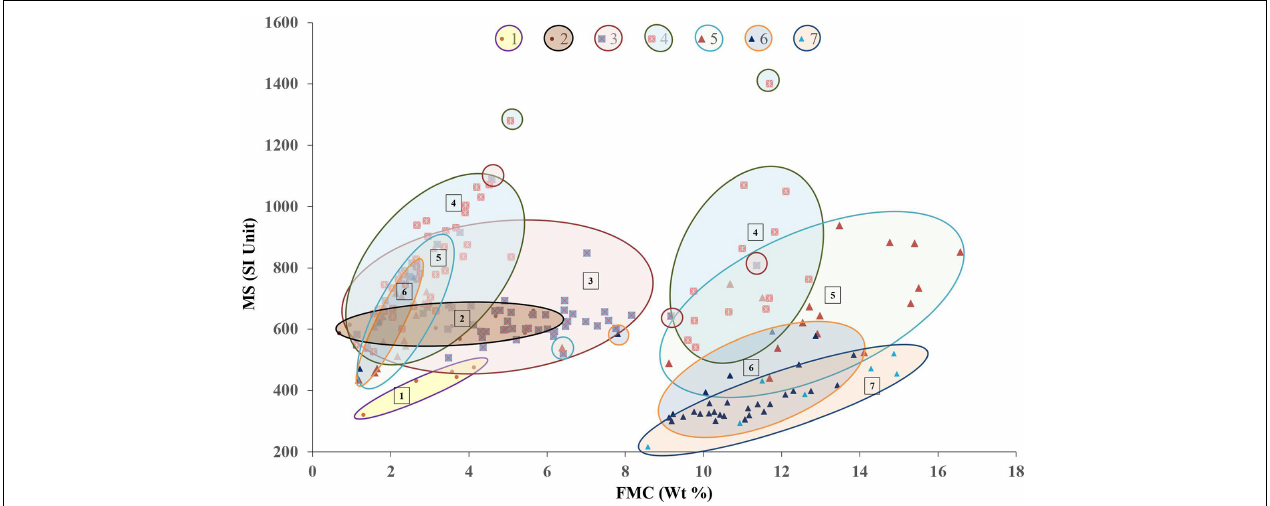
FIGURE 8 | The Cross plot of MS vs. FMC shows two groups of clusters roughly demarcated by 8% FMC. < 8% cluster includes sub-facies 1–6 and > 8% cluster includes sub-facies 4–7. The fine sub-facies, 1 is distinct and belongs to tidal influx; the other two fine sub facies 2 and 3 are a primary constituent of the overbank deposits. The overlapping/matching trend of sub-facies 2 and 3, therefore, considered capturing facies-couplets representing flood events.